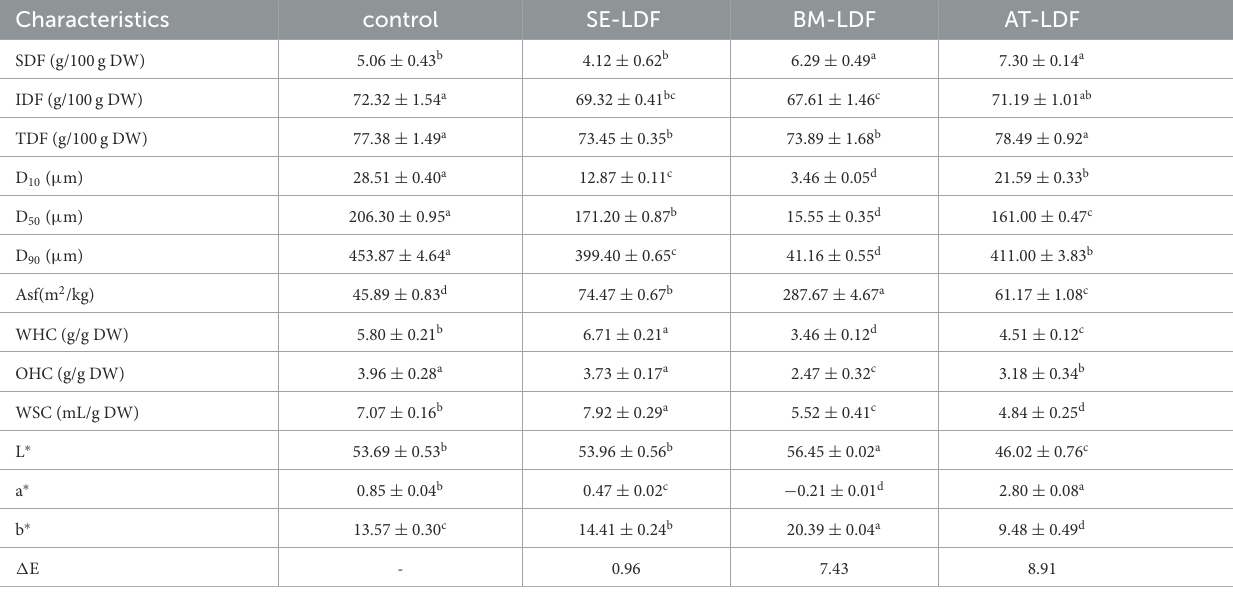
TABLE 1 Effects of modification treatment on SDF, IDF, TDF, particle size distribution, WHC, OHC, WSC, and color of LDFs.